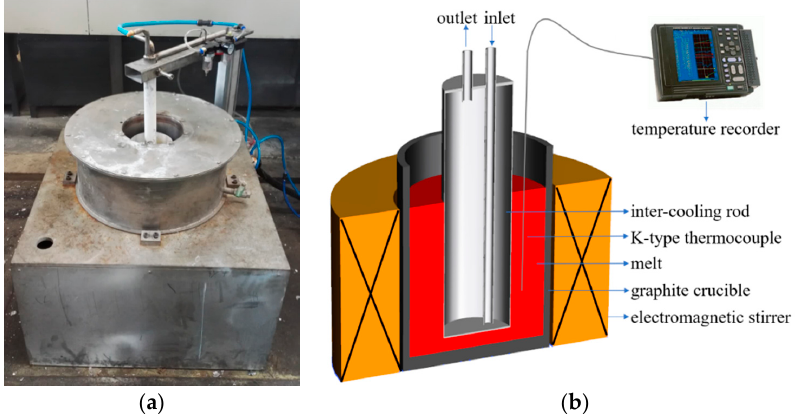
Figure 1. ( a ) Experimental facilities and ( b ) schematic diagram of internal cooling with annular electromagnetic stirring (IC-AEMS).